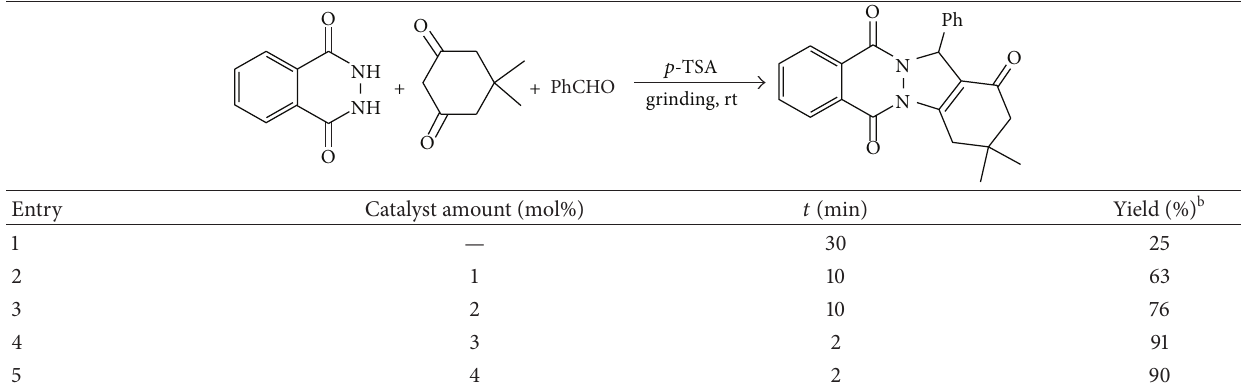
Table 1: Effect of catalyst amount on the reaction a